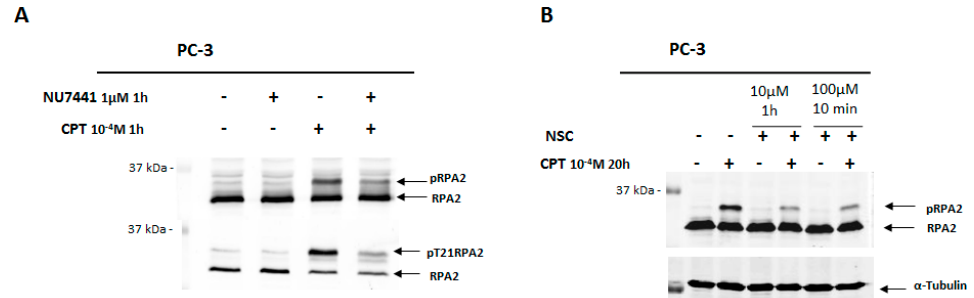
Figure 3. Assessment of DNA-PKcs activity through phosphorylation of a substrate protein RPA2 in PC-3 cells exposed to NSC. ( A ) PC-3 cells were incubated with 1 µM NU7441 (DNA-PKcs inhibitor) for 1 h, and then incubated with 100 µM CPT (topoisomerase I inhibitor) for 1 h. Phosphorylated forms of RPA were detected with anti-RPA2 and anti-pT21-RPA2; ( B ) After pre-incubation of serum-starved cells with 10 − 4 M CPT for 20 h and further incubation with 10 µM NSC for 1 h or 100 µM NSC for 10 min, the DNA-PKcs activity was analyzed by comparing the fluorescent intensity of phosphorylated RPA2 (hyperphosphorylation status) with anti-pT21-RPA2 antibody. α -Tubulin was used as an internal control.